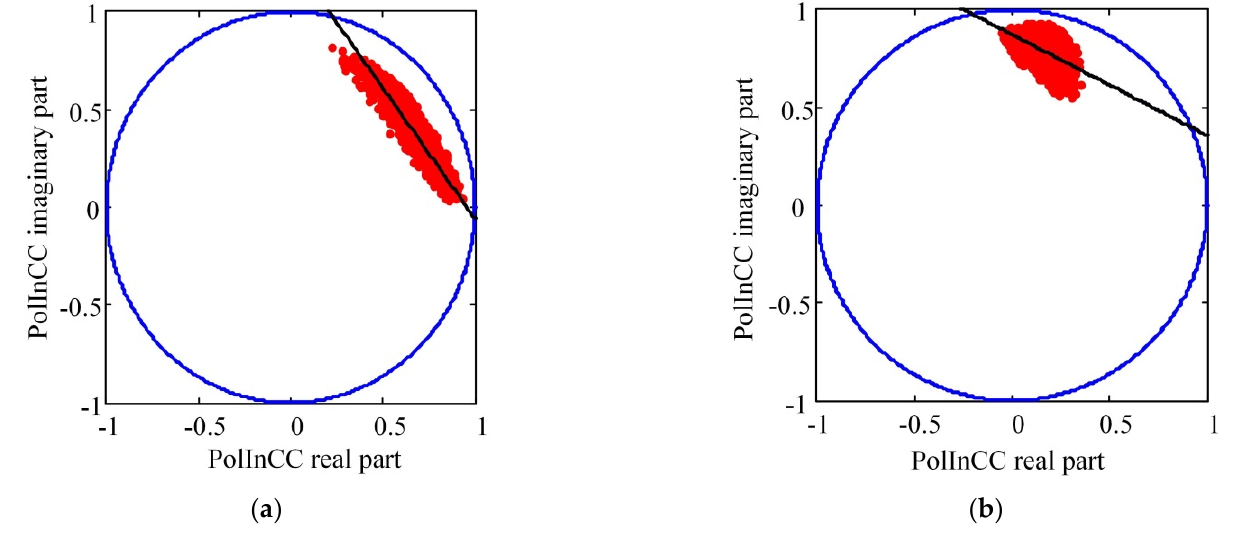
Figure 1. Distribution of PolInCCs (red dots) and straight line (black) fitting in a single pixel based on ( a ) L−band and ( b ) X−band data.